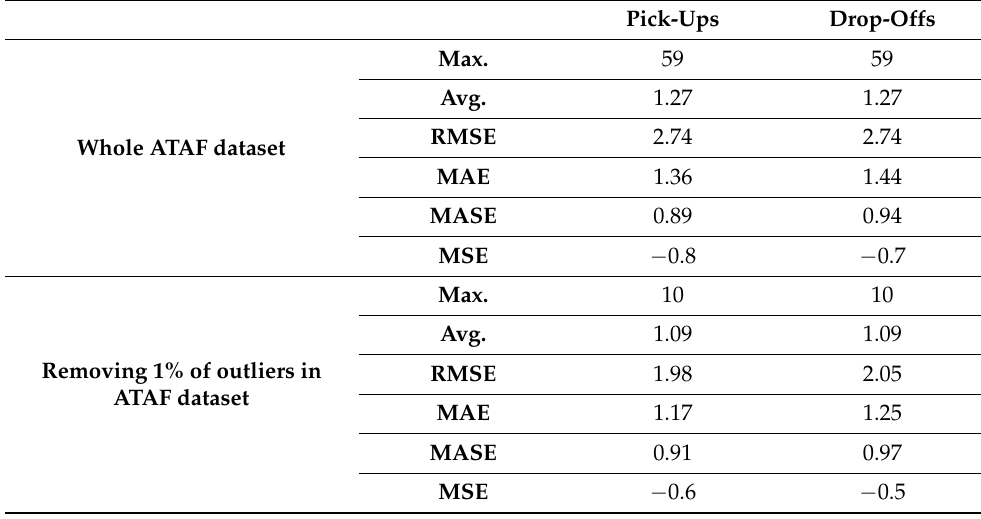
Table 5. The values of features in ATAF dataset in the city of